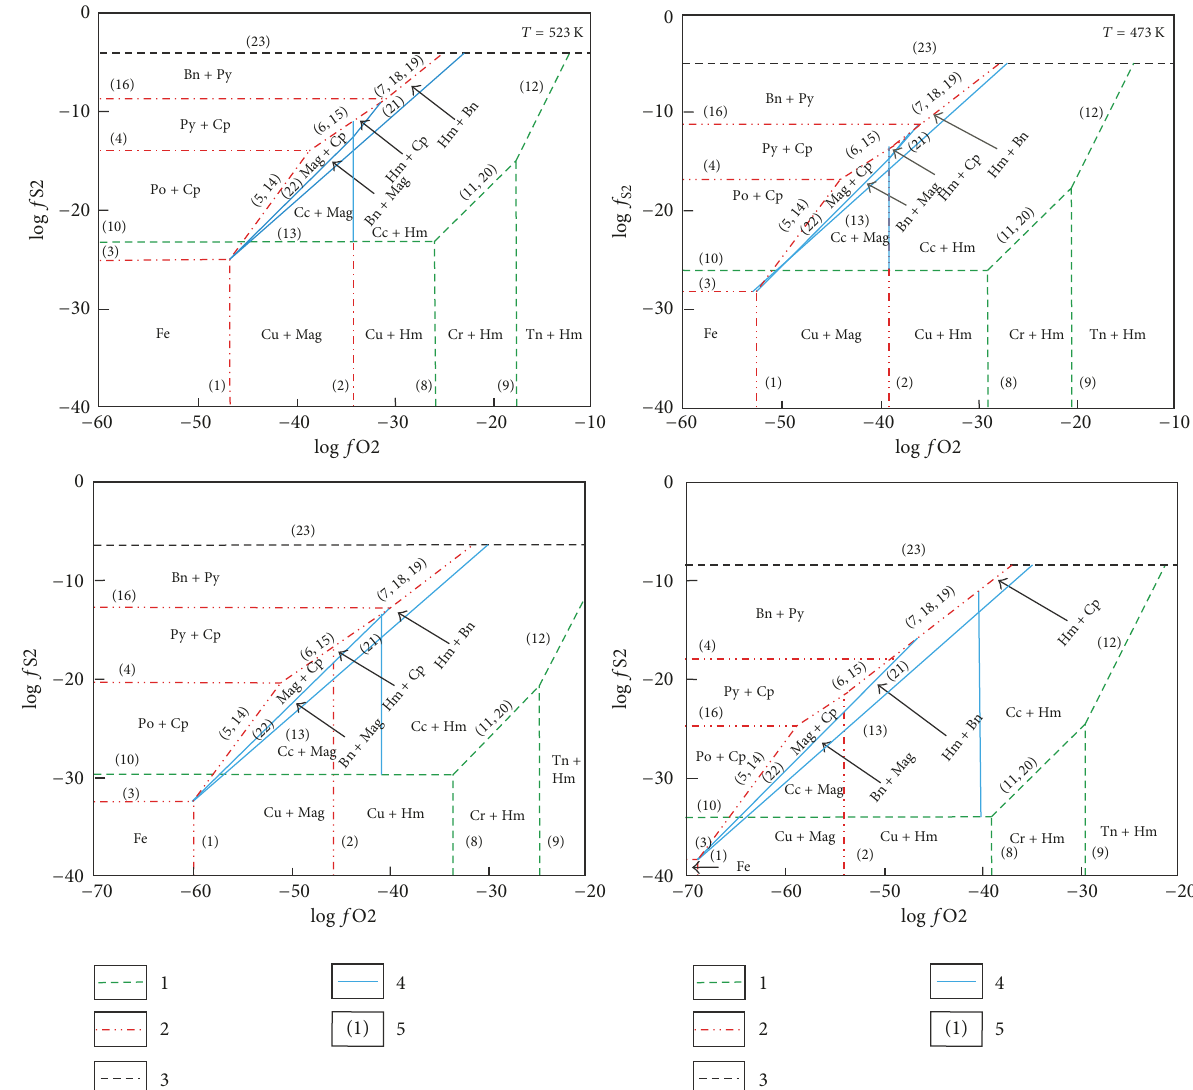
Figure 9: log 𝑓 -log 𝑓 diagram of Cu-O -S-Fe system at 373 K–523 K. 1: balance line of Cu; 2: balance line of Fe; 3: balance line of S; 4: O 2 S 2 2 balance line between sulfide and oxide; 5: number of chemical equations in Table 4; Py: pyrite; Cp: chalcopyrite; Bn: bornite; Cc: chalcocite; Hm: hematite; Mag: magnetite; Cr: cuprite; and Tn: